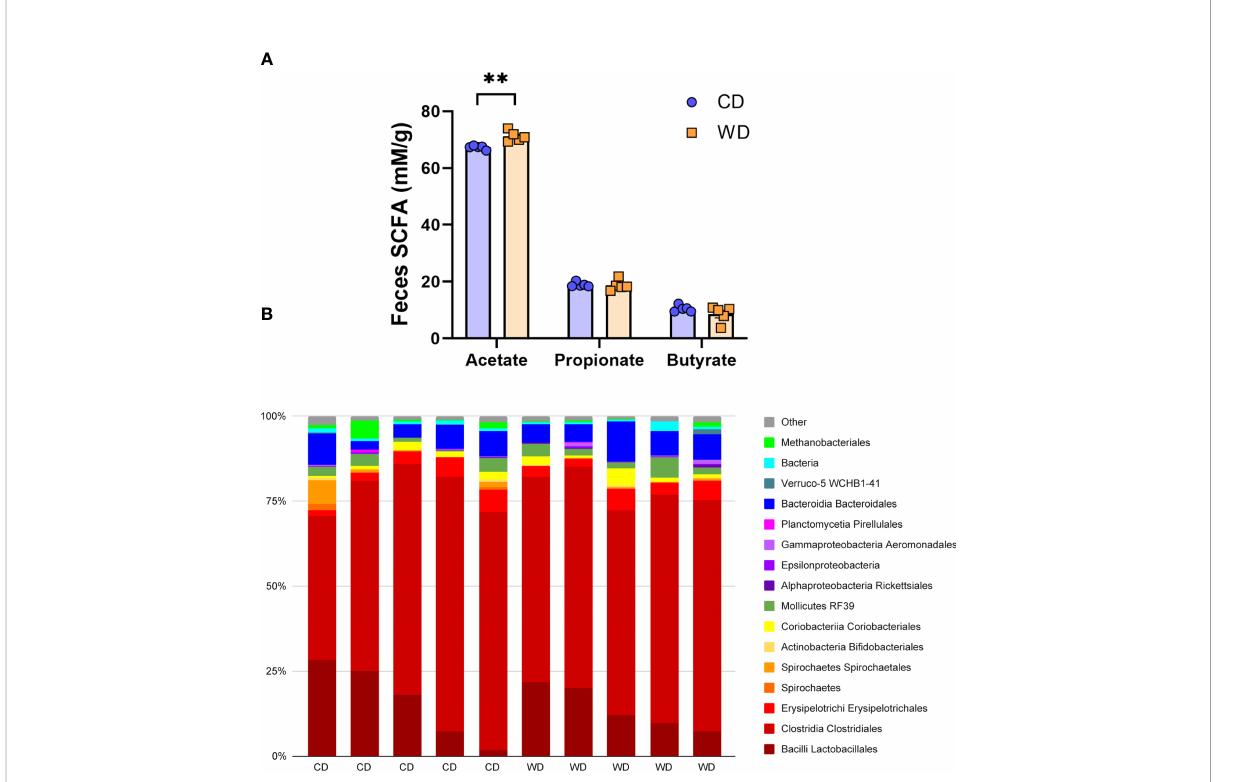
FIGURE 3 Short-duration exposure to WD induces few alterations in maternal SCFAs and microbiota. (A) Abundance of fecal SCFAs. n = 5/group. Unpaired 2-tailed Student ’ s t test was used to test signi fi cance. ** P < 0.01. (B) Microbial abundances for each gut sample, clustered at the order level. Orders comprising less than 0.5% total abundance are displayed as “ Other ”